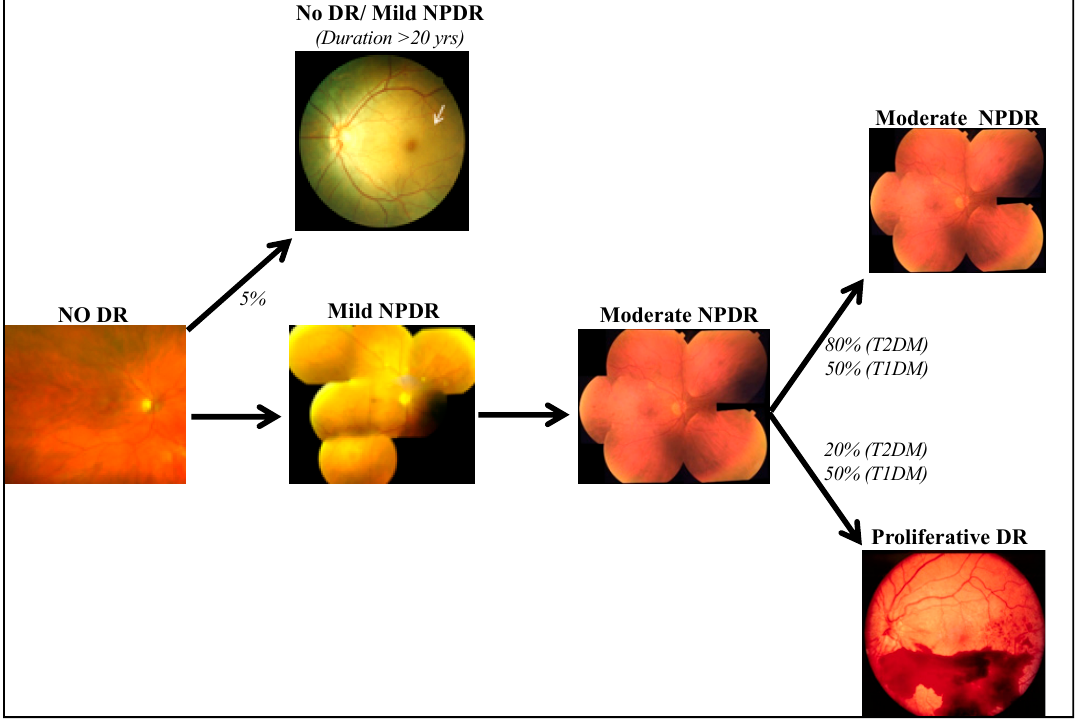
Figure 2. Based on our clinical observations and large epidemiological studies, the hypothesis proposed is that not every diabetic retinopathy (DR) patient goes through the same sequence of events. After a period of diabetes, patients can develop mild non-proliferative diabetic retinopathy (NPDR), followed by moderate NPDR. 20% of type 2 diabetes patients develop proliferative diabetic retinopathy (PDR) while 50% of type 1 diabetes patients develop PDR. In PDR patients, only 15% develop concurrent diabetic macular edema (DME), and the other 85% never develop any macular edema. Interestingly, ~5% diabetic patients never develop DR or only have mild NPDR (1 or 2 microaneurysms, as indicated by white arrow), in spite of 20 or more years of diabetes (“Extreme Phenotype”). Images of mild NPDR and moderate NPDR phenotypes courtesy of the ETDRS Diabetic Retinopathy severity scale Ophthalmology (1991).